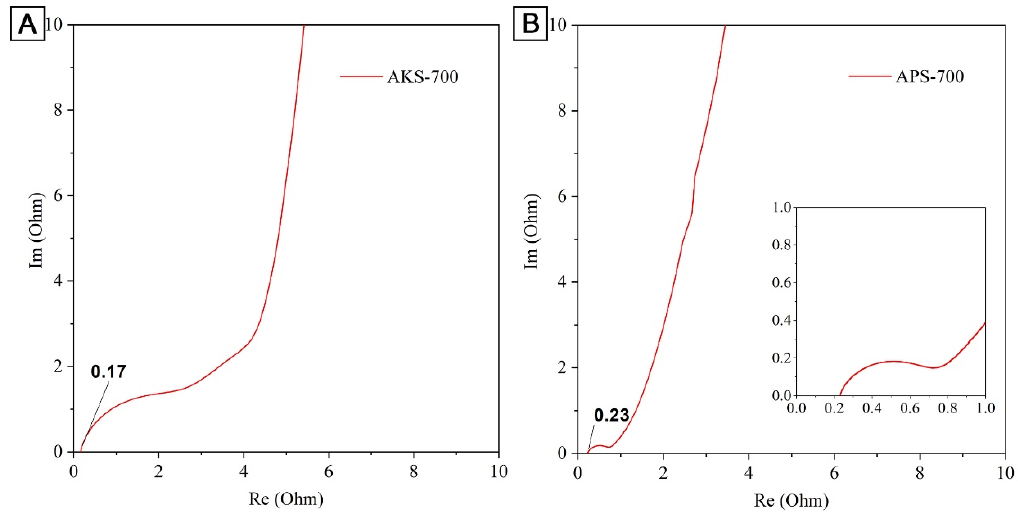
Figure 7. Nyquist plot for activated sawdust electrodes ( A ) AKS-700 and ( B ) APS-700. Solution resistance (Rs), which corresponds to the beginning of the semicircle, of the sample AKS-700 is 0.17 Ohm, whereas the Rs of the sample APS-700 is 0.23 Ohm. The magnitude of charge transfers resistance (Rct) can be obtained from the diameter of the semicircle. Rct of APS-700 is approximately 0.6